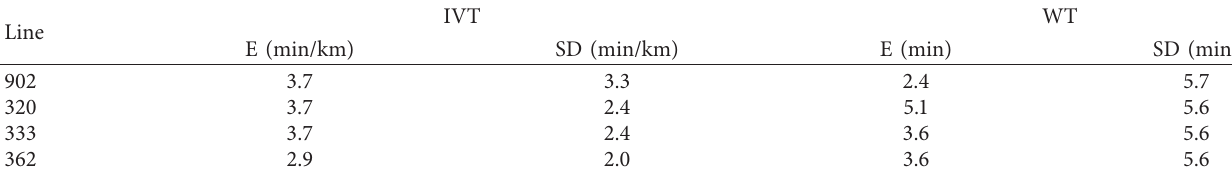
Table 7: Expectation and standard deviation of IVT and